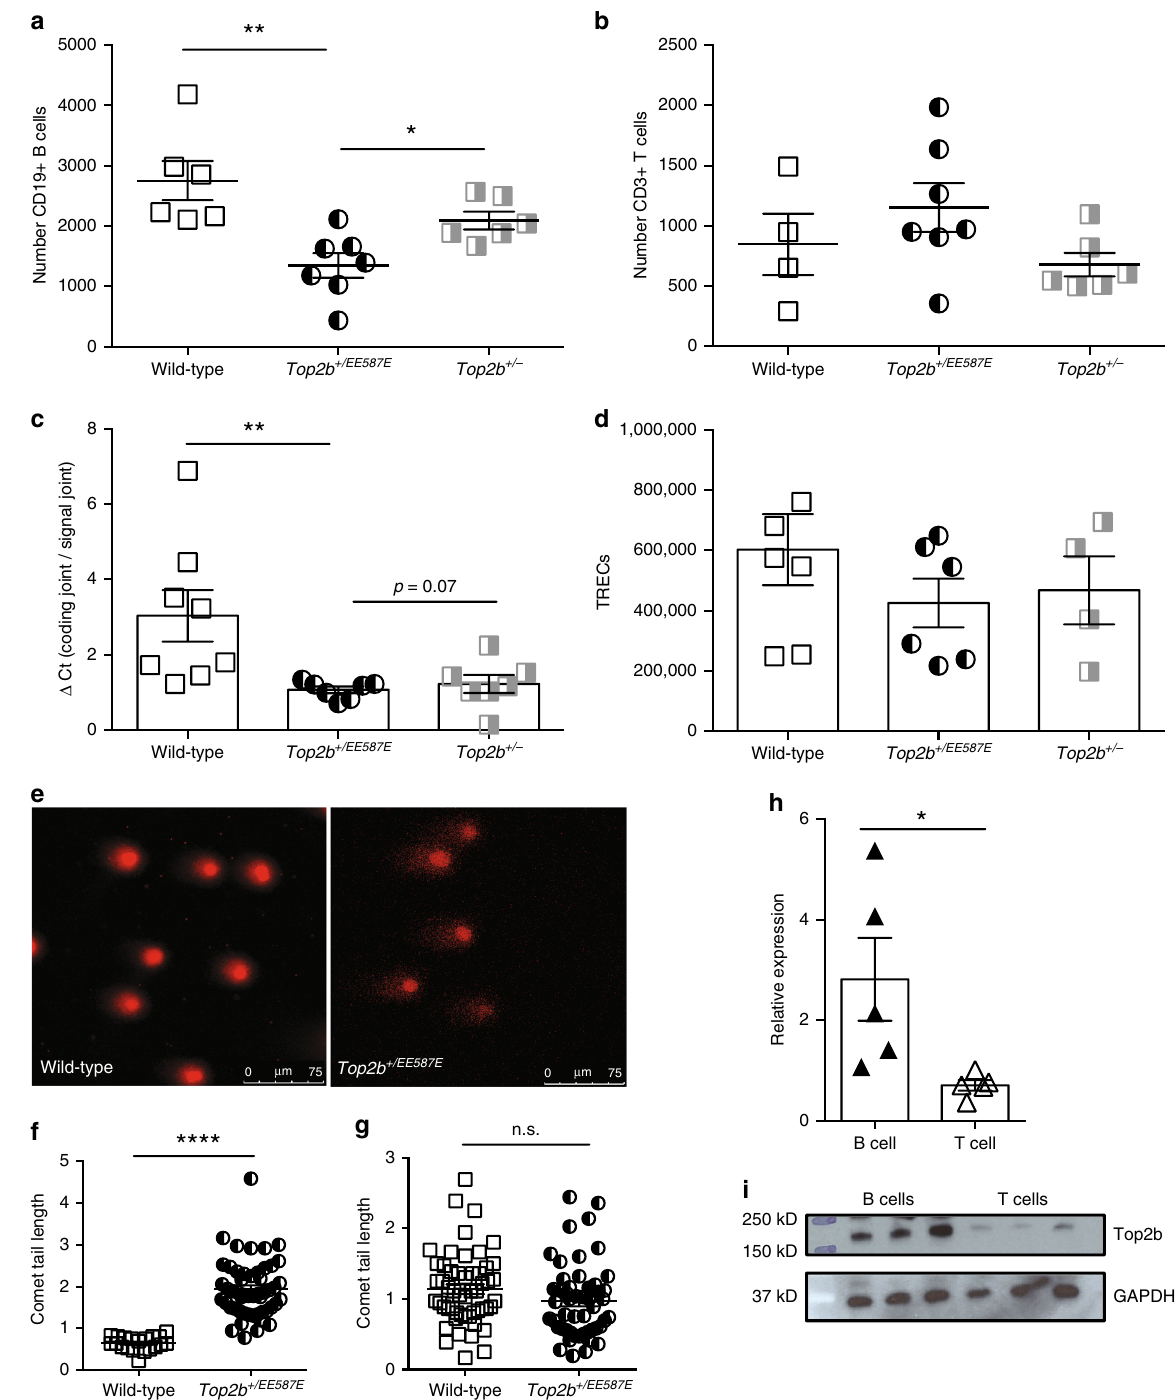
Fig. 6 Heterozygous mutation in Top2b negatively affects B-cell development beyond haploinsuf fi ciency. Expression of mutant Top2b ( n = 7) results in reduced CD19 + B cells ( a ) in peripheral blood compared to wild-type ( n = 6) or hemizygous mice ( n = 6), while T cells ( b ) are unaffected.(shown as mean ± SEM, * p < 0.05, ** p < 0.005, two-tailed Student ’ s t test). c qPCR analysis of kappa-deleting recombination excision circles demonstrates that B cells isolated from Top2b + /EE587E ( n = 7) or Top2b + / − mice ( n = 7) have a less robust replication history compared to wild-type mice ( n = 8 mice), shown as mean ± SEM, while T-cell proliferation as measured by T-cell receptor excision circle (TREC) formation is unaffected ( d ), ( n = 6 WT, 6 mutant and 4 hemizygous mice, performed with technical duplicates shown as mean ± SEM). * p < 0.05, ** p < 0.005, one-way ANOVA. e – g Comet assay shows increased DNA strand breaks in B cells ( e , f ) isolated from Top2b + /EE587E mice compared to wildtype, expressed as comet tail length. T cells ( g ) are not affected ( n = 3 mice per group, 10 images per mouse (X40); * p < 0.05; **** p < 0.0001, by Kruskal – Wallis test ( f ), or nonsigni fi cant (n.s.) by Student ’ s t test ( g )). h , i Expression of Top2b is elevated in wild-type B cells compared to wild-type T cells by RT-qPCR ( h , n = 5 mice, performed in technical triplicates, shown as mean ± SEM, * p < 0.05, two-tailed Student ’ s t test), and immunoblot ( i , protein isolated from B and T cells from three wild-type mice, representative of four experiments; source data are provided as a Source Data fi